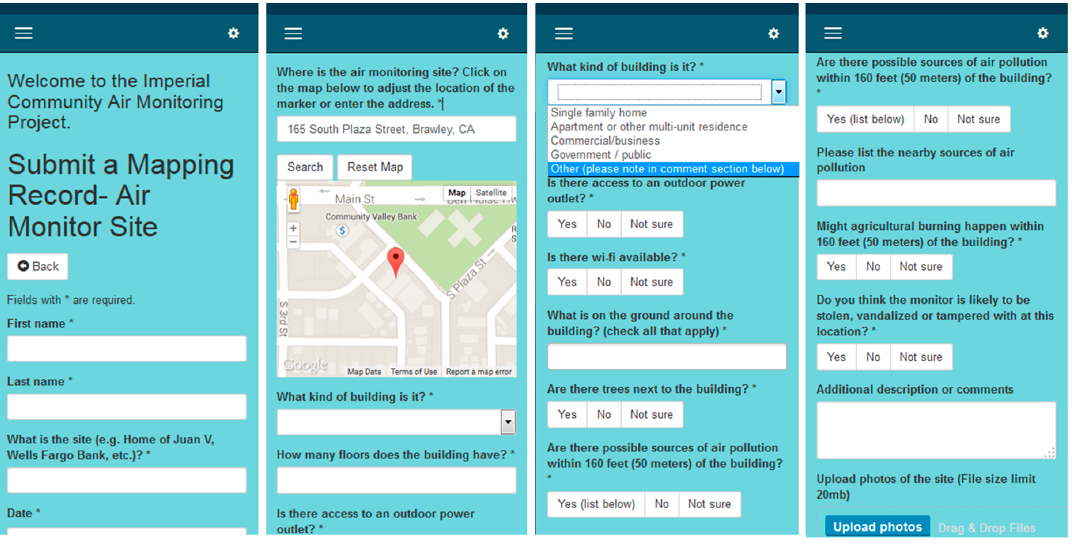
Figure 2. Screenshots of mobile web form used for data collection.